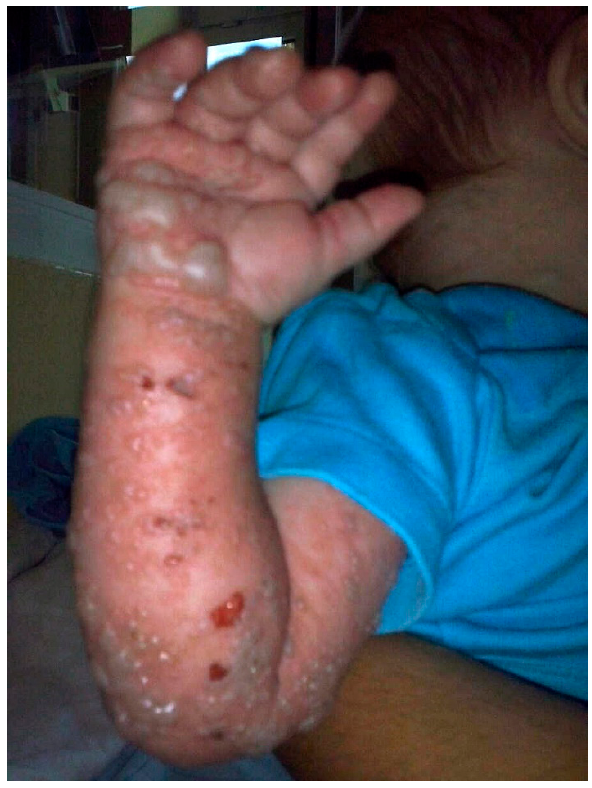
Figure 1. Severe course of Varicella Zoster in the described case. Table 1. A,B. Laboratory test results. A—hospitalization at the age of 9 months, B—hospitalization at the age of 13 months.